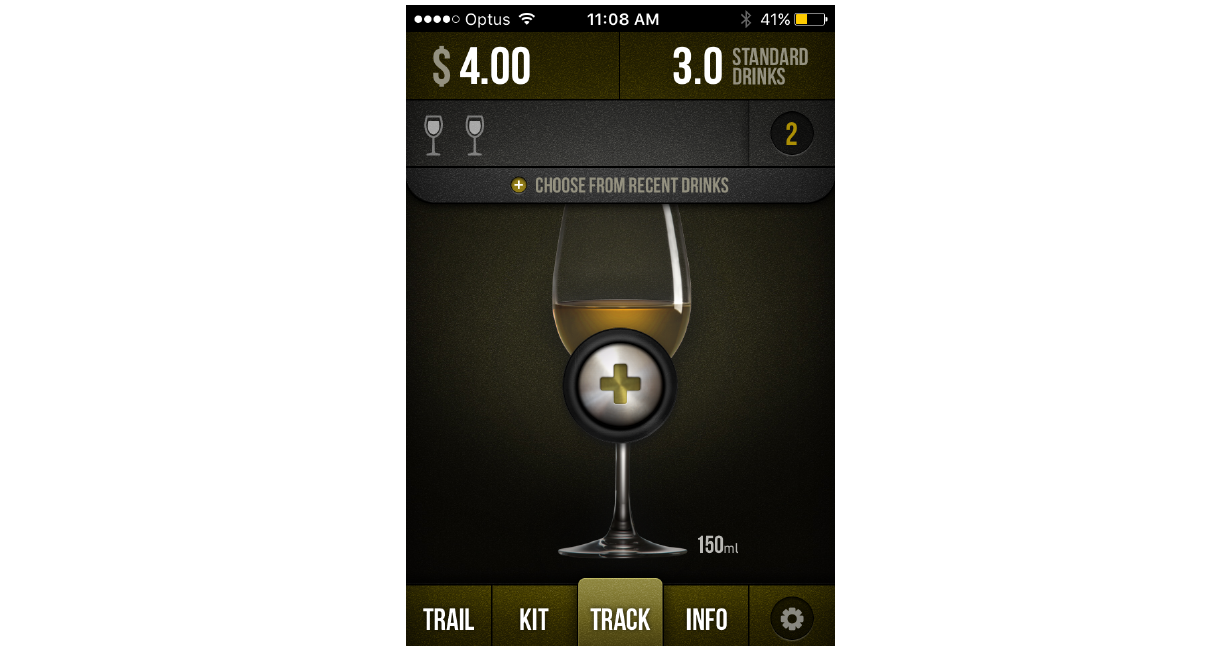
Figure 2. OnTrack Screenshot